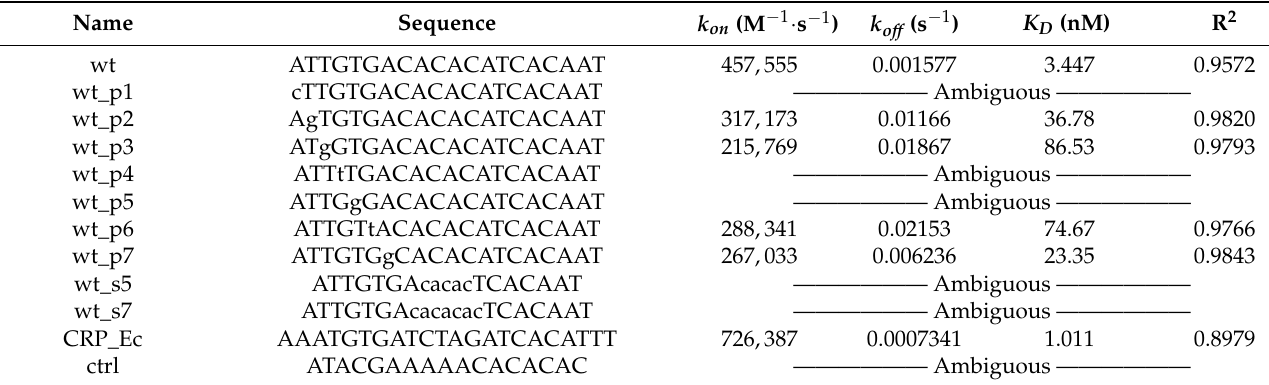
ATACGAAAAACACACAC (Sequence) Lowercase nucleotides indicate a mutation from the TTHA1359 consensus sequence (wt). (CRP_Ec) Consensus DNA-binding sequence for CRP EC [6]. (Ambiguous) Kinetic parameters could not be determined conclusively for the concentrations of TTHA1359 investigated. For these DNAs, estimated K D > 1000